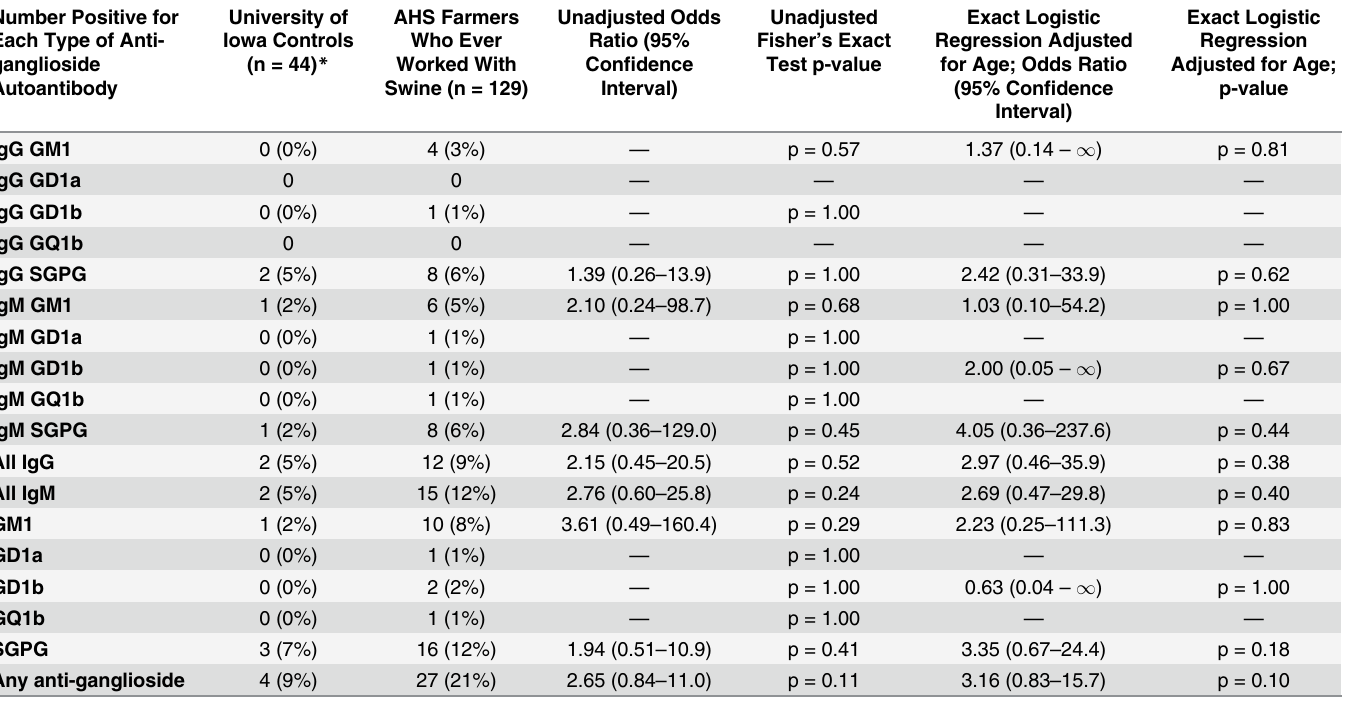
Table 5. Anti-ganglioside Autoantibodies: Farmers vs. Controls (n = 173) * . Number Positive for Each Type of Anti- ganglioside